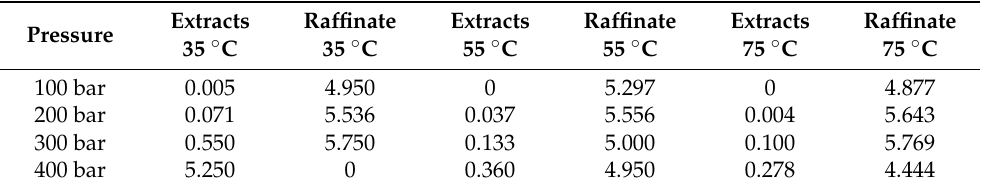
Table 4. Extract and raffinate flowrates (g/min) registered when fractionating crude borage oil by means of a countercurrent column